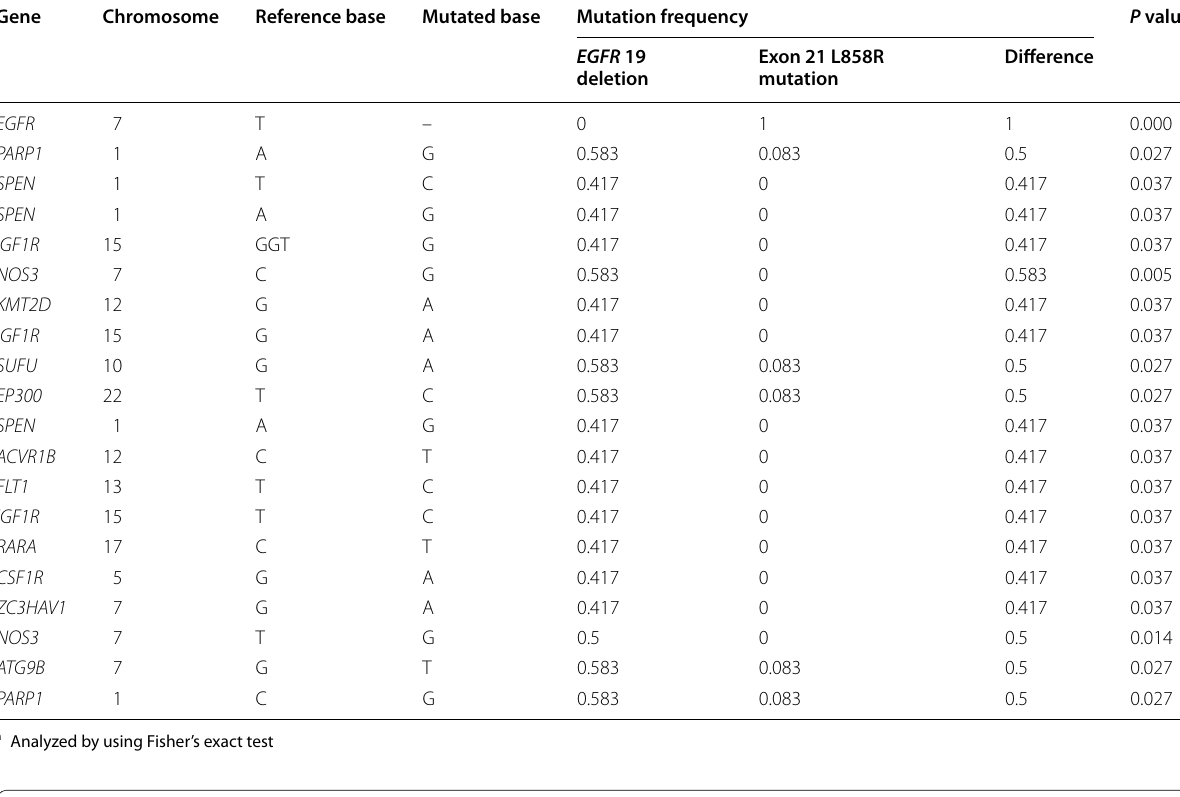
Table 5 List of genes differentially expressed between the EGFR exon 19 deletion and exon 21 L858R mutation groups Gene